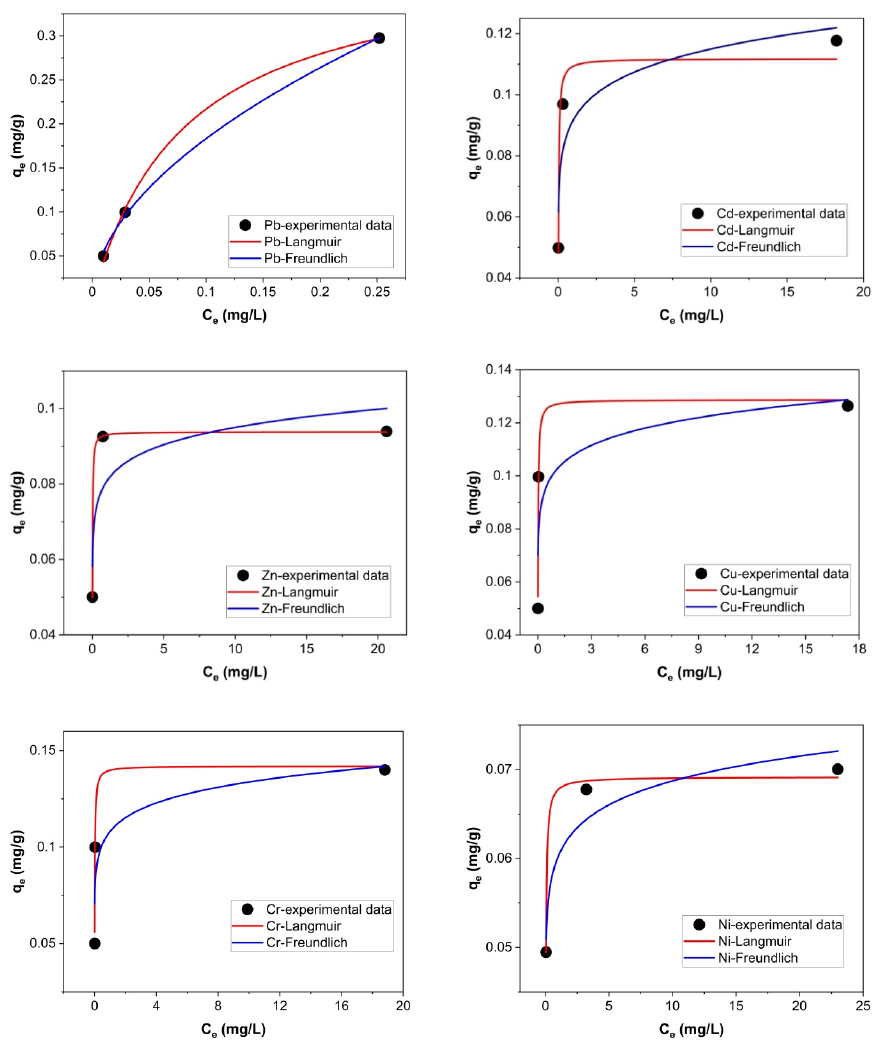
Figure 8. Nonlinear fitting of Langmuir and Freundlich isotherm models for the Pb, Cd, Zn, Cu, Cr and Ni ions sorption onto zeolite with a 0–0.05 mm particle size thermally treated at 200 °C. The Langmuir and Freundlich isotherm parameters are given in Table 4. Table 4. Langmuir and Freundlich isotherm parameters for Pb, Cd, Zn, Cu, Cr, and Ni ions sorption onto zeolite with a 0–0.05 mm particle size thermally treated at 200 °C.